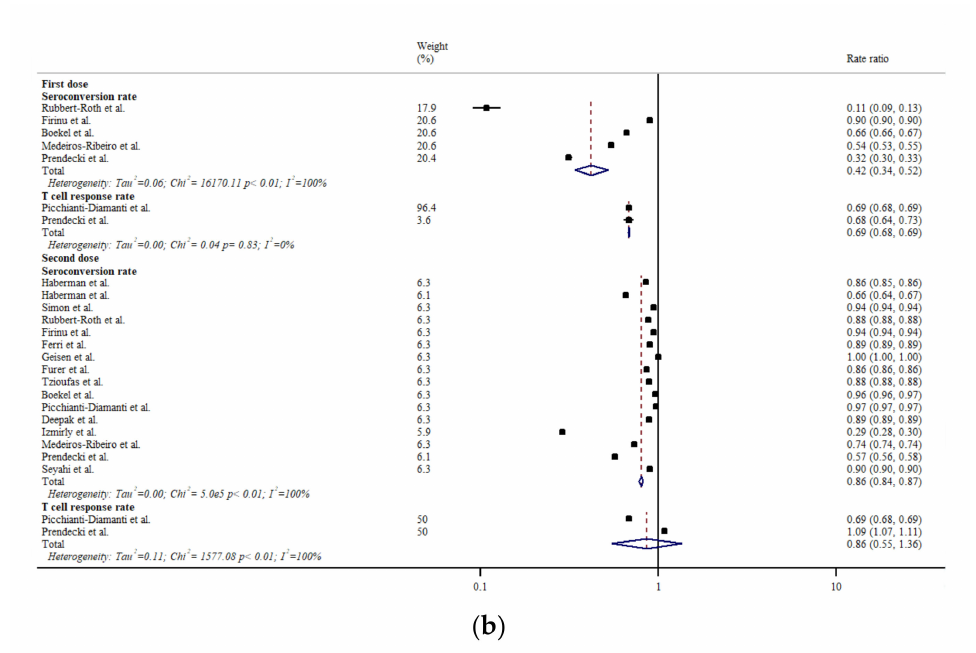
Figure 2. ( a ) The immunogenicity of mRNA vaccines in rheumatic patients, and ( b ) the rate ratios of immunogenicity between rheumatic patients and healthy controls. The black squares represent the effect estimates of the individual studies and the diamonds represent the summary effect estimates.